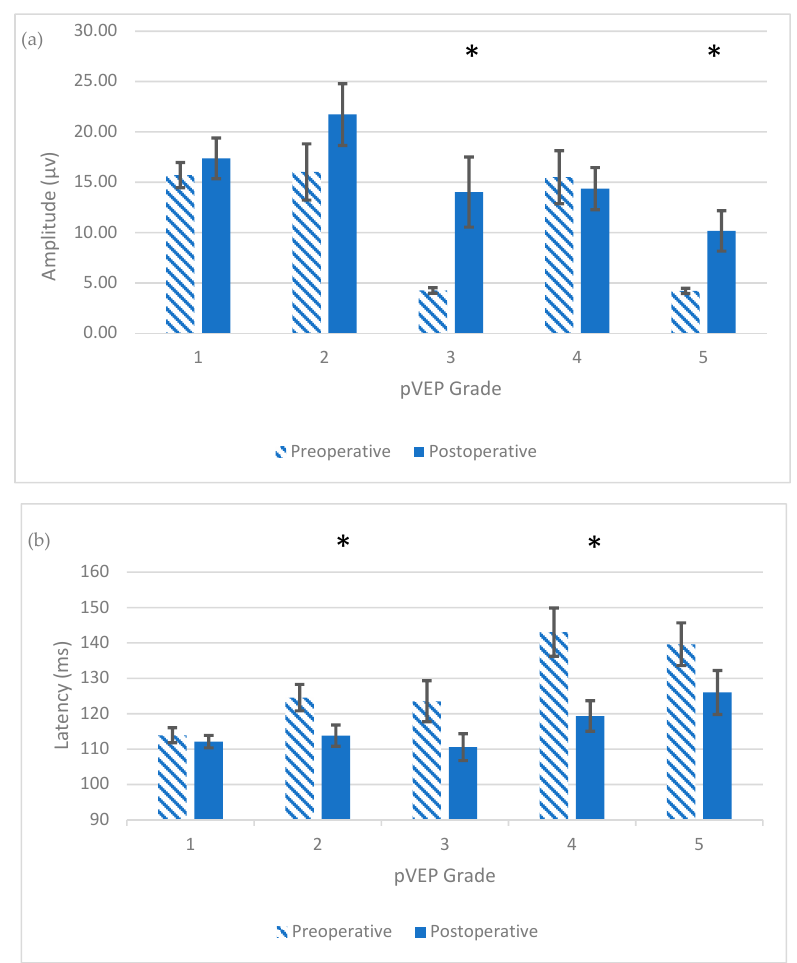
Figure 3. Postoperative changes in the means of pVEP amplitude ( a ) and latency ( b ), in each preoperative pVEP grade within 6 months after surgery, with the standard error of mean bars shown; ( a ) *, Significant postoperative increase in pVEP amplitude; p < 0.05; ( b ) *, Significant postoperative decrease in pVEP latency; p < 0.05.